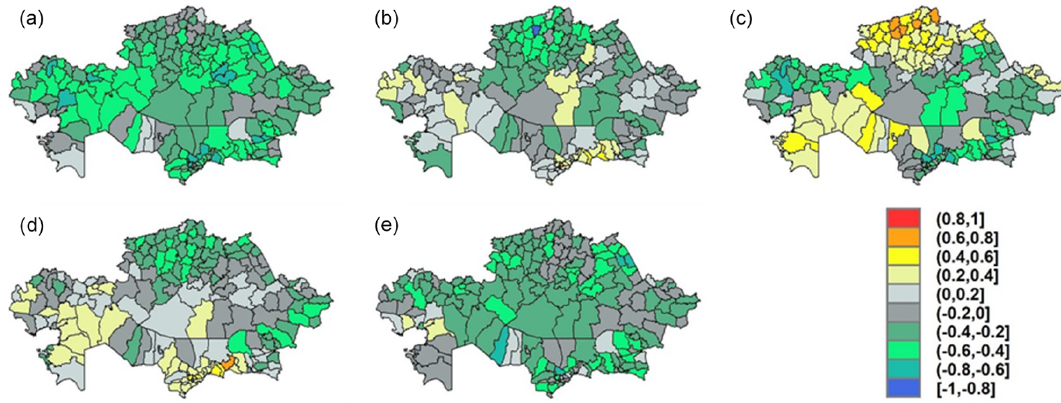
Figure 6. Pairwise robust rank correlations of fraction of burned area with (a) year, (b) PDSI, (c) proportion of grassland layer, (d) ANPP and (e) livestock density without considering their